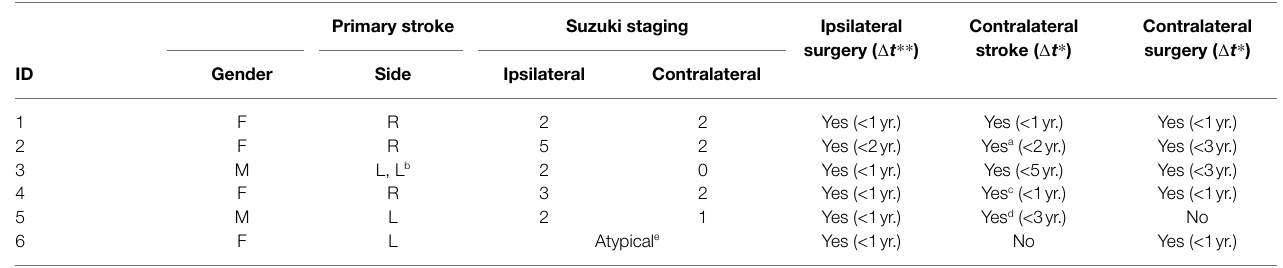
TABLE 1 | Summary of the MMD patient cohort ( n =